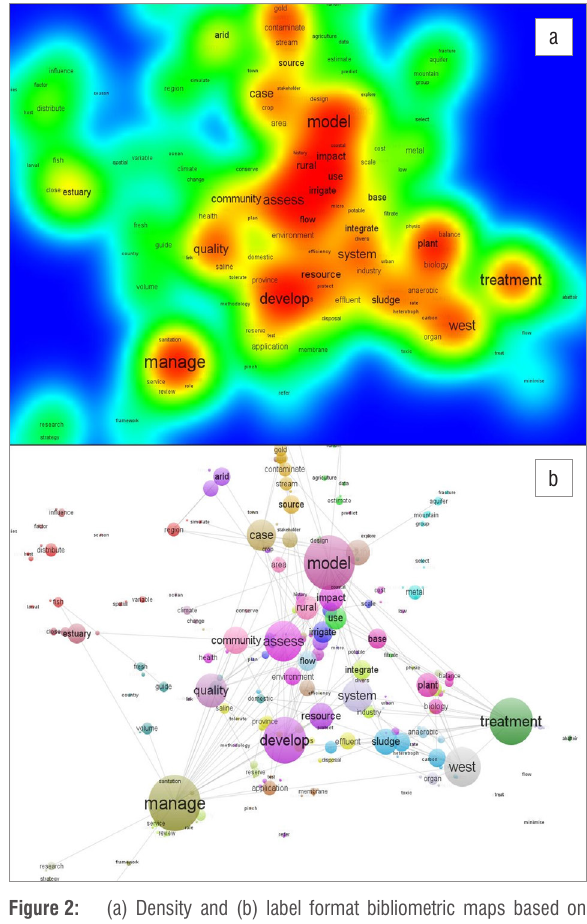
Figure 2: (a) Density and (b) label format bibliometric maps based on keywords in publications from 2002 to 2006 ( n